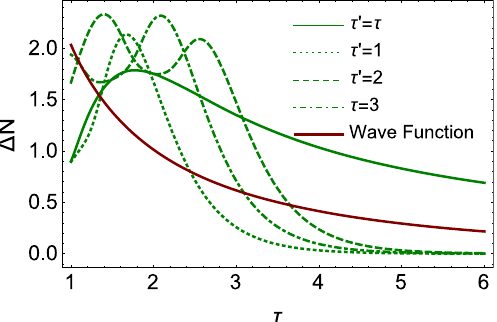
(cid:10) Fig. 2 Δ N 2 ≡ d ϕ δ N 2 versus τ = r Q s at different value of τ (cid:5) = r (cid:5) Q s . ϕ is the angle between r and r (cid:5) . For N G we use the solution to Eq. (12) with N 0 = 0.05. The red line presents the overlapping integral (see Appendix B) with r = r (cid:5) for Q 2 s = 9GeV 2 (cid:10) (cid:3) (cid:2) (cid:21) z dz (cid:5) N N ( z ) = z (cid:5) and z = ln τ 2 with τ = r Q s . where